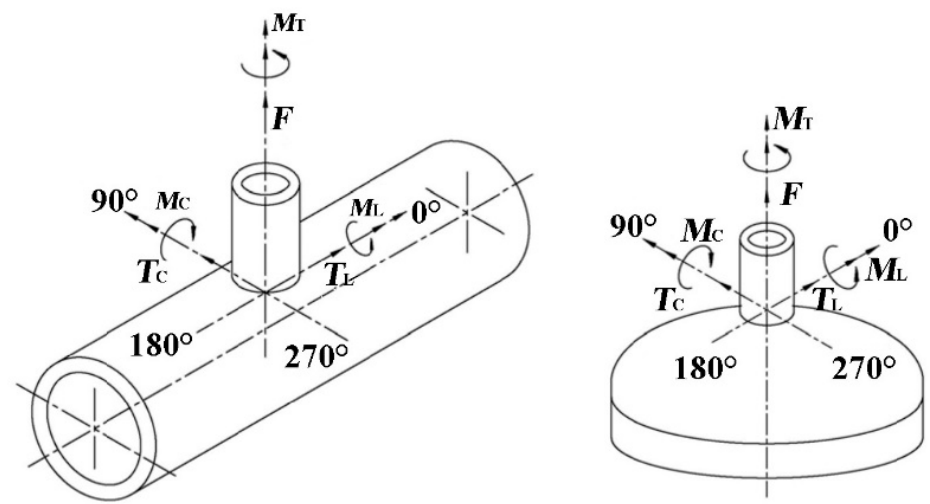
Figure 3. The direction of pipe